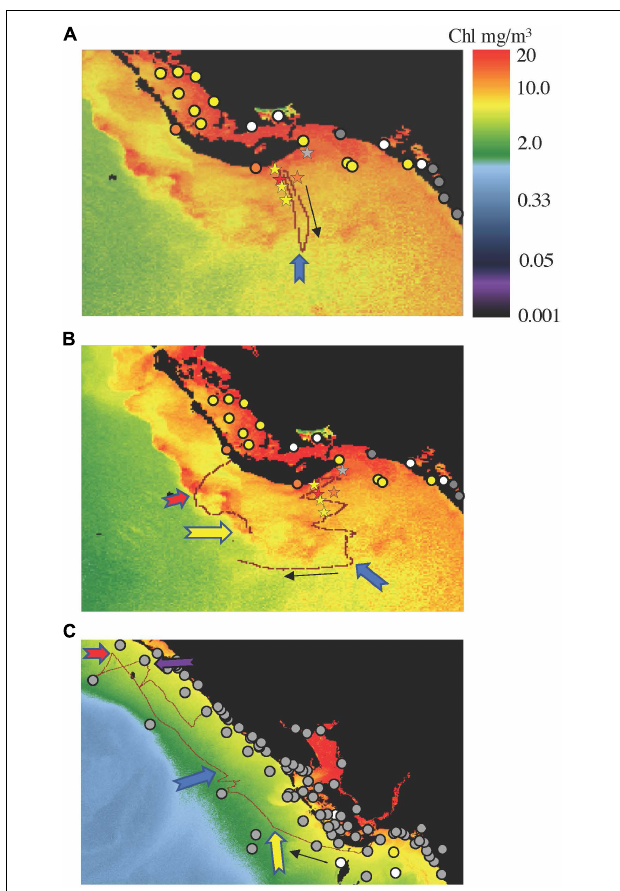
FIGURE 6 | Nav2 deployment tracks (red line) overlain upon Sentinel3A OLCI satellite imagery, as well as enumerated K. brevis cell count data from the Florida Fish and Wildlife Commission (circles) and the Sanibel-Captiva Conservation Foundation (stars). A satellite track image from December 17, 2019 is used to represent the December 18–19, 2017 (A) and December 20–23, 2017 track (B) , while the January 31–February 6, 2018 track is on an image from February 2, 2018 (C) . The black arrows indicate the direction of the Nav2 track, and the colored block arrows indicate specific locations in the transect that correspond to those in the time-series data in Figure 7 . Discrete samples collected and enumerated for K. brevis cells are within 1 week of the deployment in (A,B) but 1 month of the deployment in (C) as sampling was less intense because the major bloom temporarily dissipated. Gray indicates not present/background levels, white indicates very low densities > 1,000–10,000 cells L − 1 , yellow indicates low